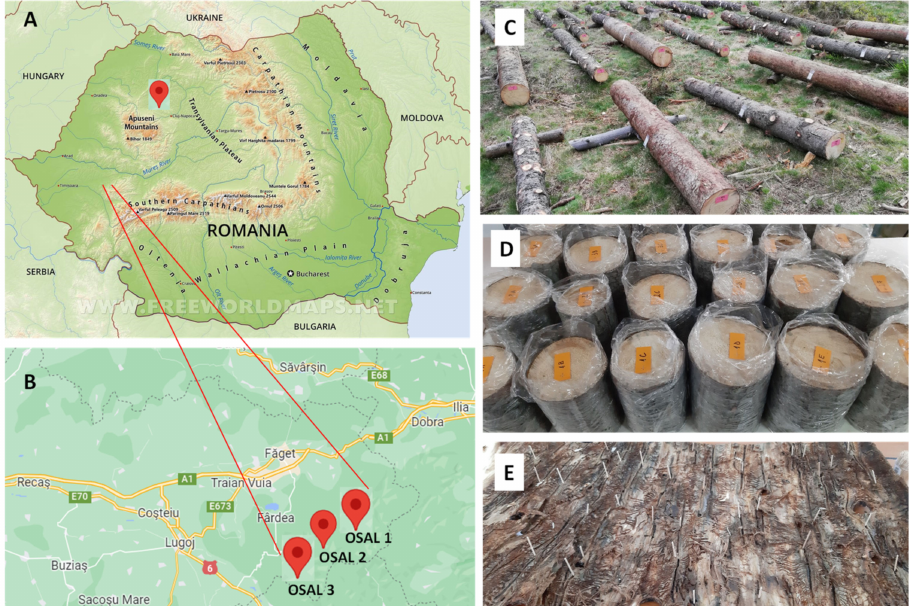
Figure 1. Experimental sites ( A , B ) (Google Map); plots with stems of branches of 1 m-long sections with diameters between 16 and 22 cm ( C , D ); galleries of I. typographus adults and larvae ( E